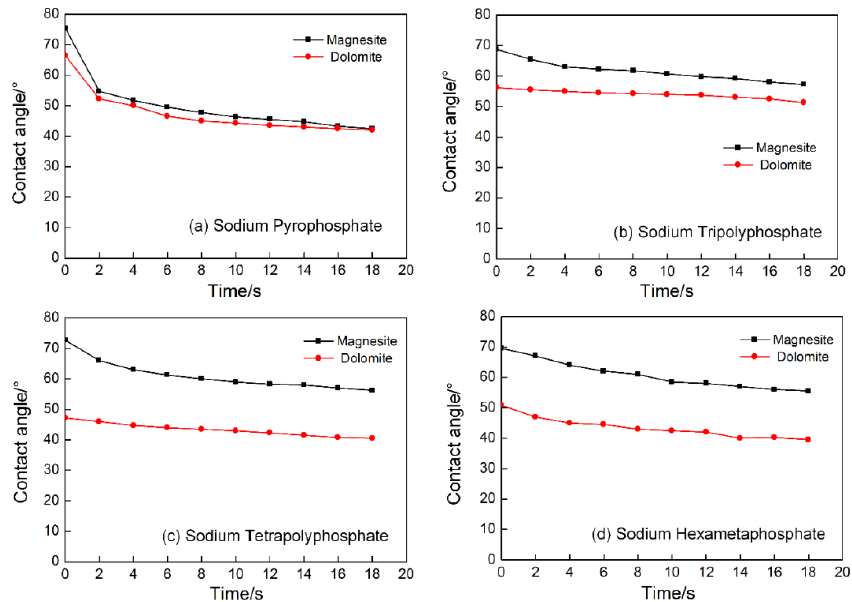
Figure 7. The relationship between contact angle and time under the effect of the sodium phosphate salts. Sodium Oleate 3 × 10 − 4 mol / L. ( a ) Sodium Pyrophosphate 300 mg / L, ( b ) Sodium Tripolyphosphate 200 mg / L, ( c ) Sodium Tetrapolyphosphate 100 mg / L, ( d ) Sodium Hexametaphosphate 4 mg / L.